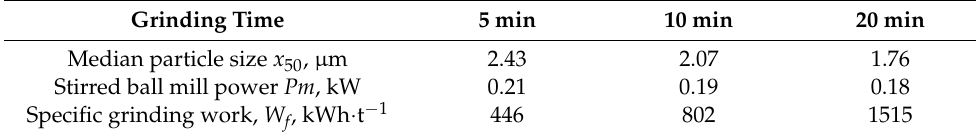
Table 5. Specific grinding work for wet grinding in a laboratory stirred ball mill. Grinding Time 5 min